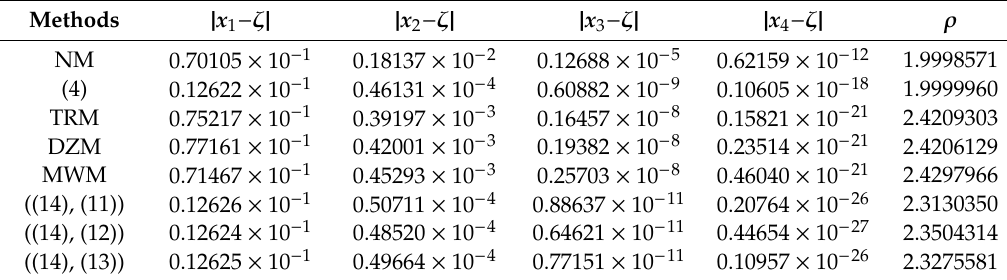
Table 2. Numerical results for function f 2 ( x )